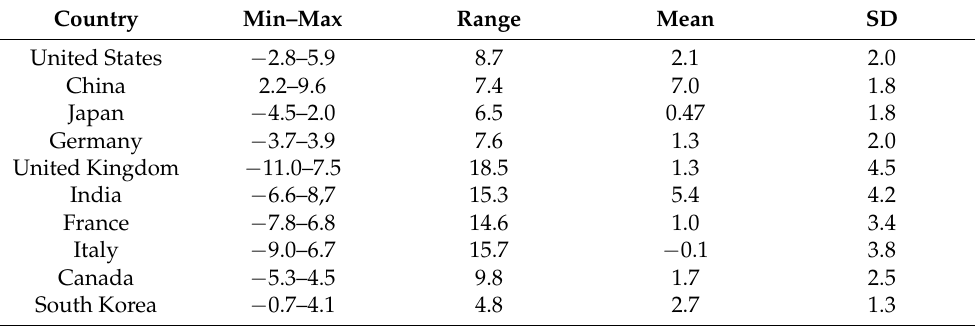
Table 2. Variability of the GDP growth rates (%) for the TOP-10 world economies in 2011–2021.